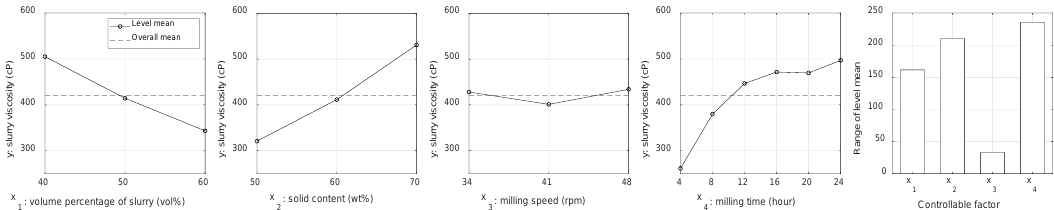
Figure 5. ( a ) main effect plot for x 1 ; ( b ) main effect plot for x 2 ; ( c ) main effect plot for x 3 ; ( d ) main effect plot for x 4 ; ( e ) ranges of level means for x 1 , ..., x 4 .